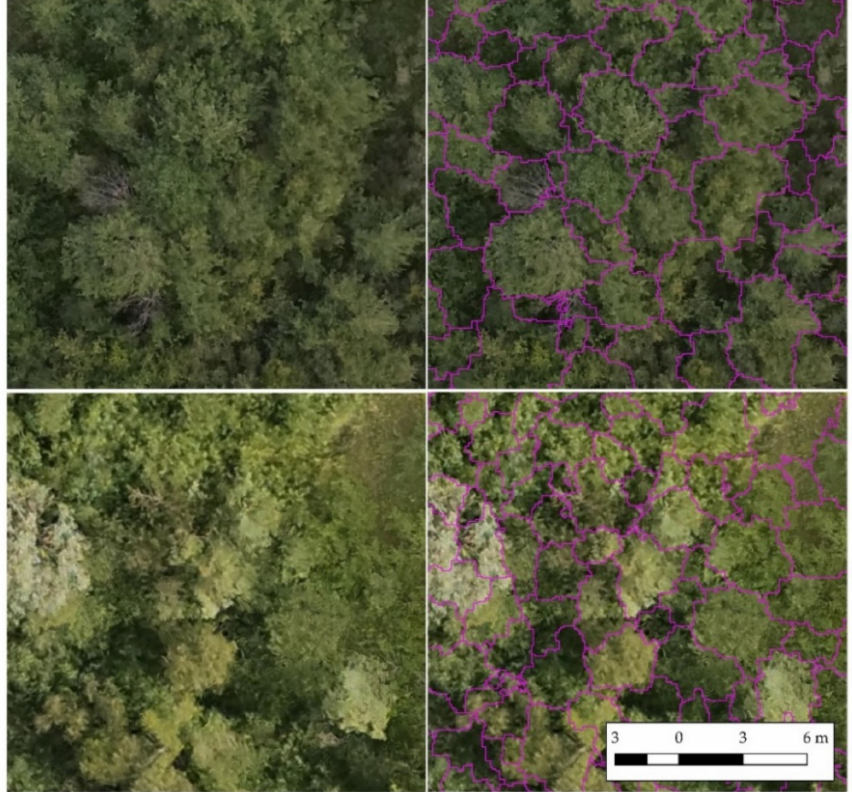
Figure 3. Examples of the segmentation results. Different areas and different backgrounds: epoch II ( bottom ) and epoch III ( above